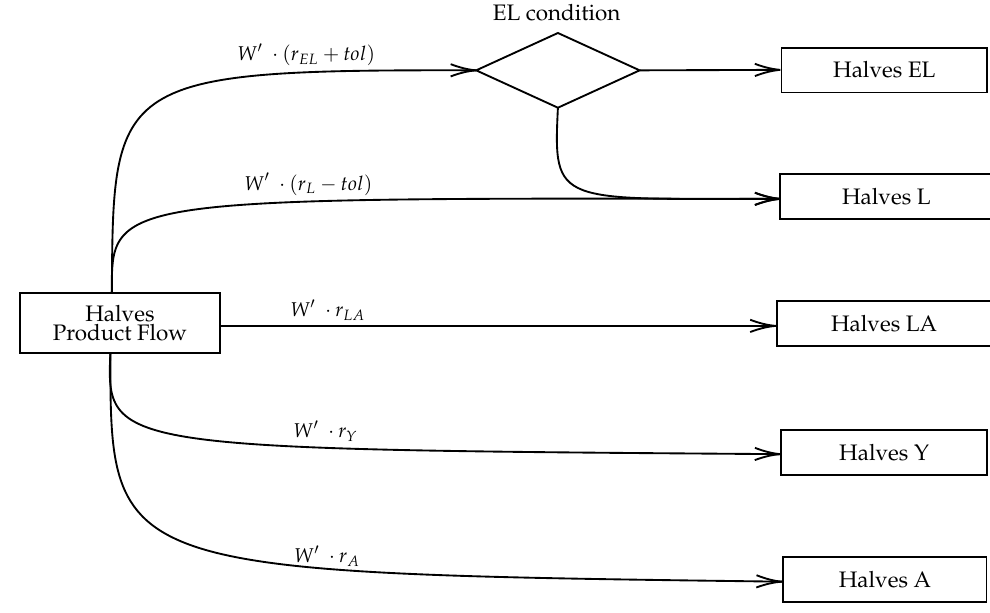
Figure 3. Halves products.